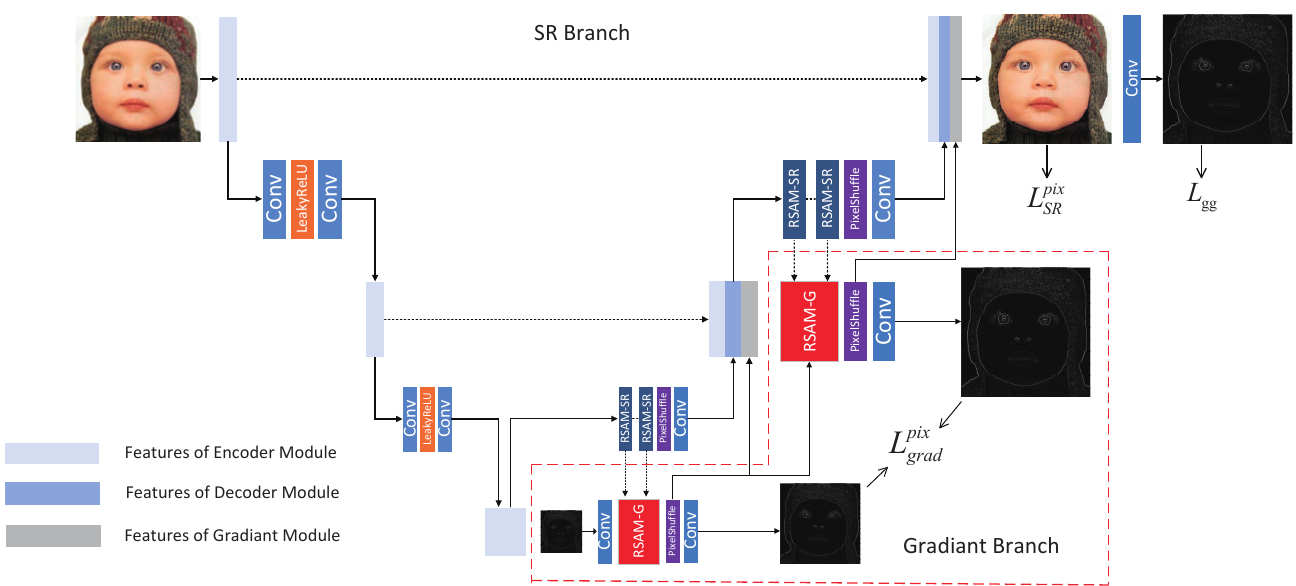
Figure 1. Network architecture of our Gradient-Prior-based Super-Resolution network (GPSR). The network consists of two branches, the gradient branch (bottom right), which is used to generate the multi-scale spatial structure feature maps, and the SR branch (upper left), which is used to generate the final reconstructed image. Notably, the intermediate features generated on the SR branch are integrated into the gradient branch to provide additional beneficial structural features. In addition, the multi-scale spatial structure feature maps generated on the gradient branch are integrated into the SR branch to strengthen the edge and texture